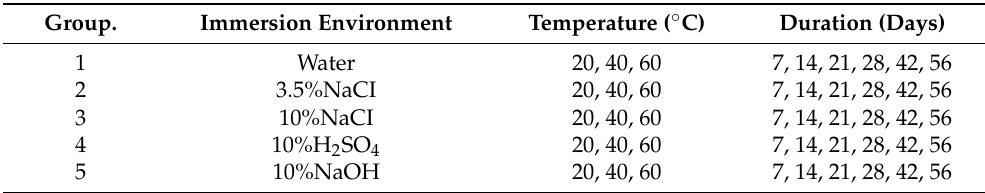
Table 1. Immersion conditions for five groups.